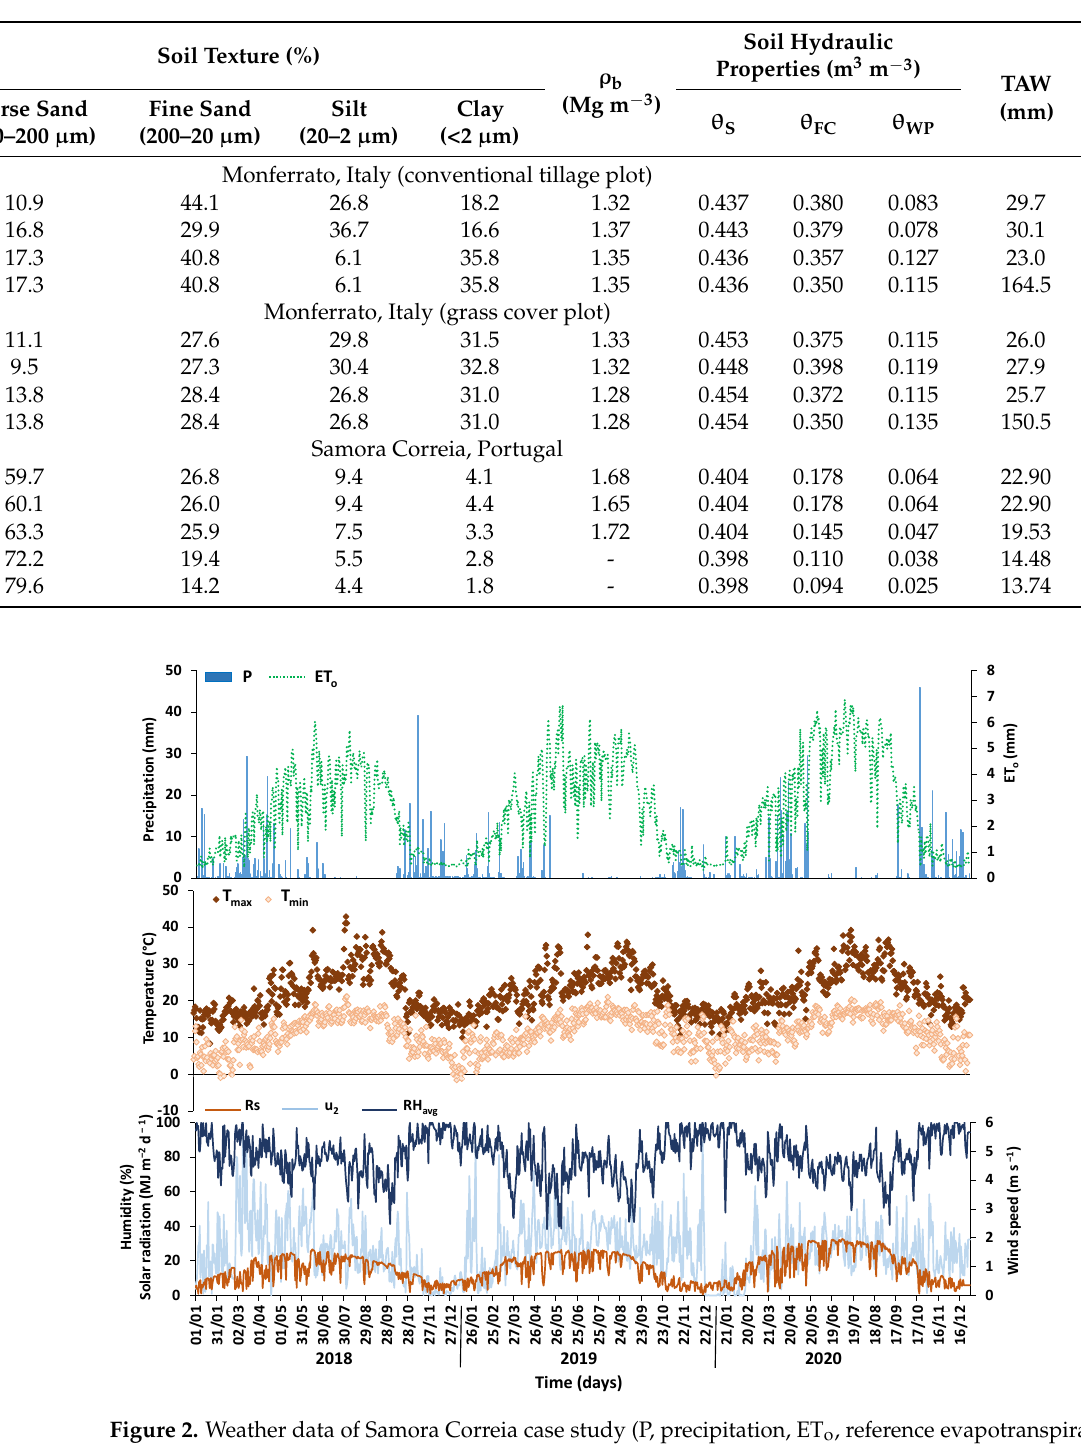
Table 1. Main soil physical characteristics in the different case studies ( ρ b , soil bulk density; θ S , θ FC , θ WP , soil water contents at saturation, field capacity, and the wilting point, respectively; TAW, total available water).